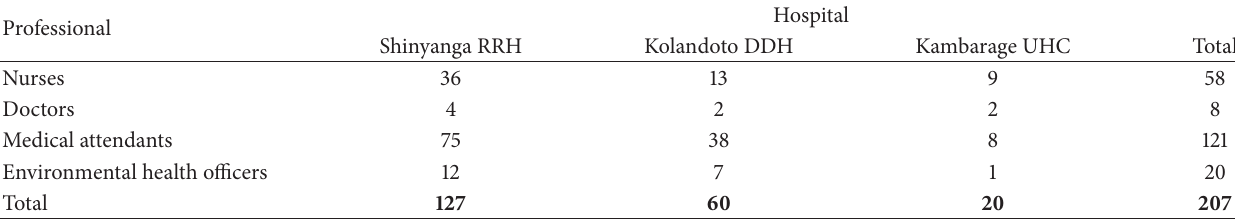
Table 1: Employees participating in providing information during the